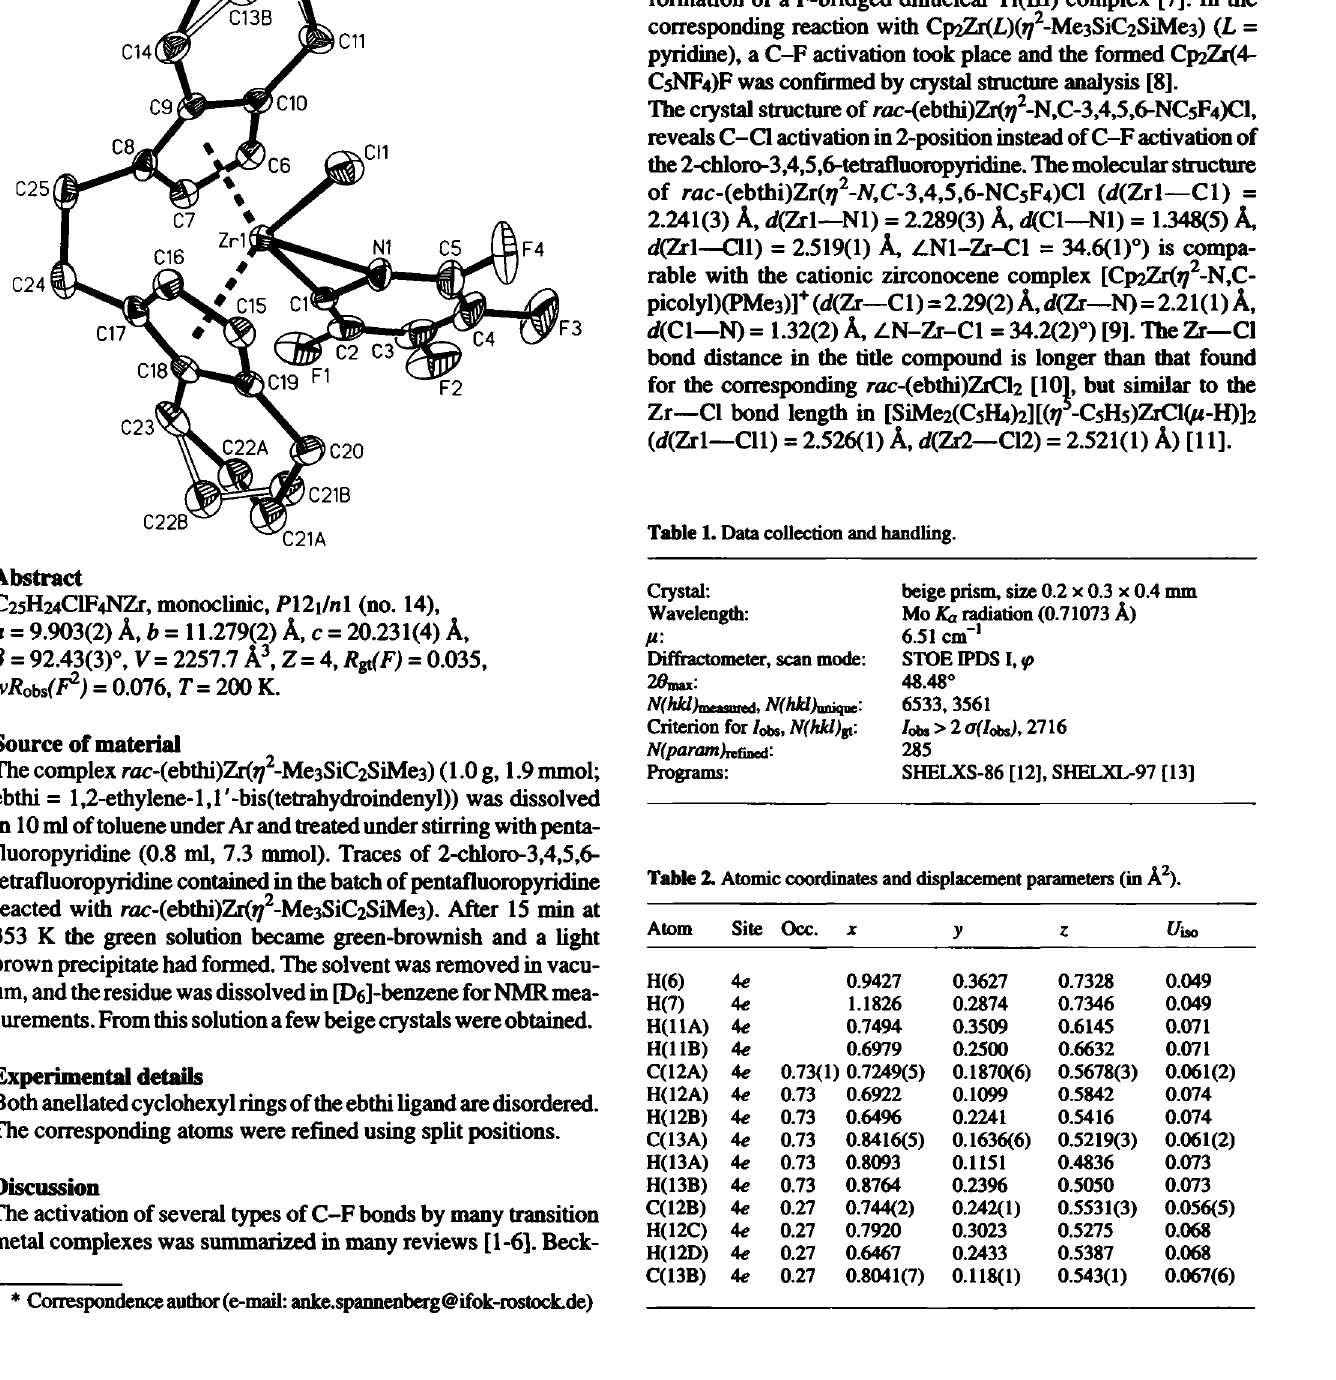
Table 2. Atomic coordinates and displacement parameters (in A 2